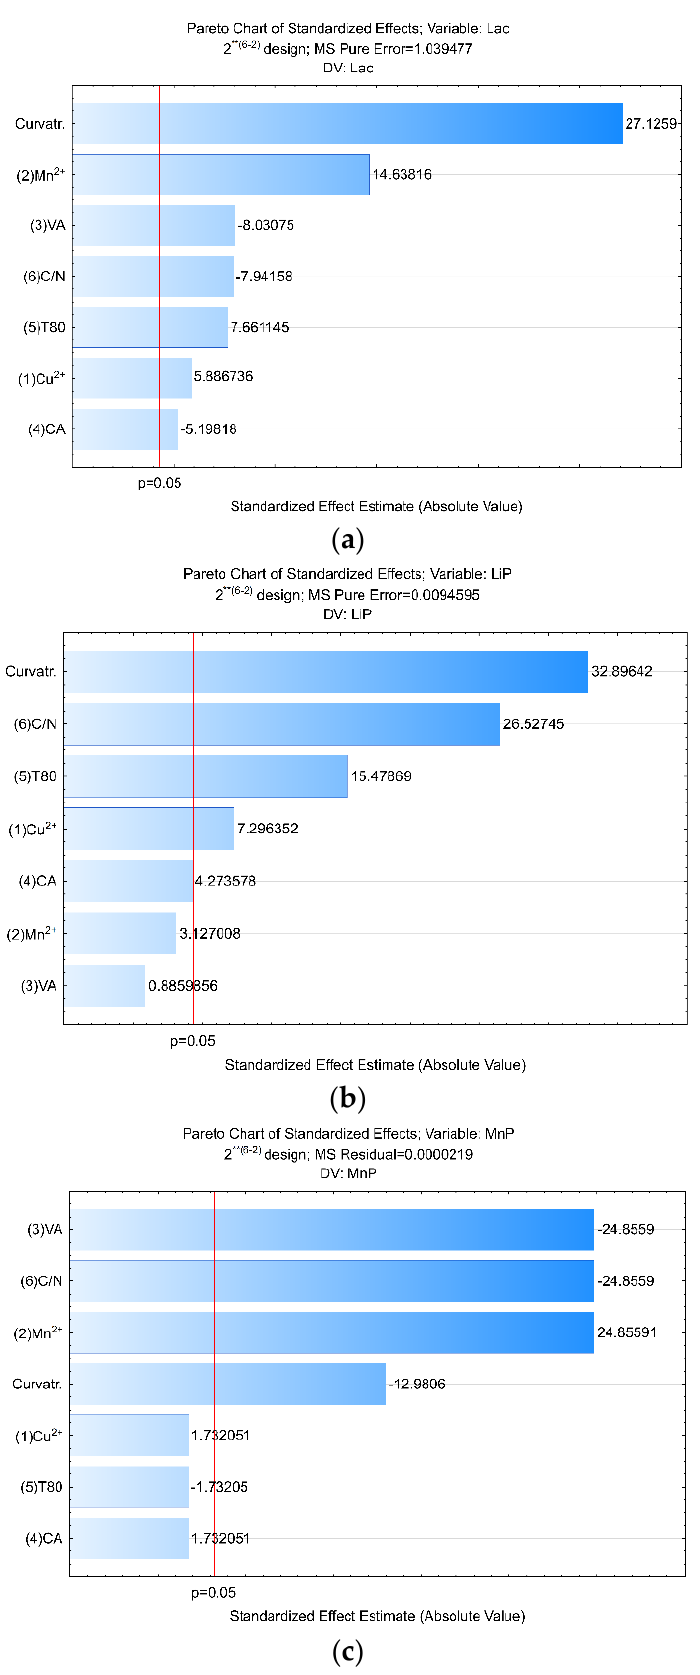
Figure 1. Pareto chart from factorial design with (a) Lac, (b) LiP and (c) MnP.